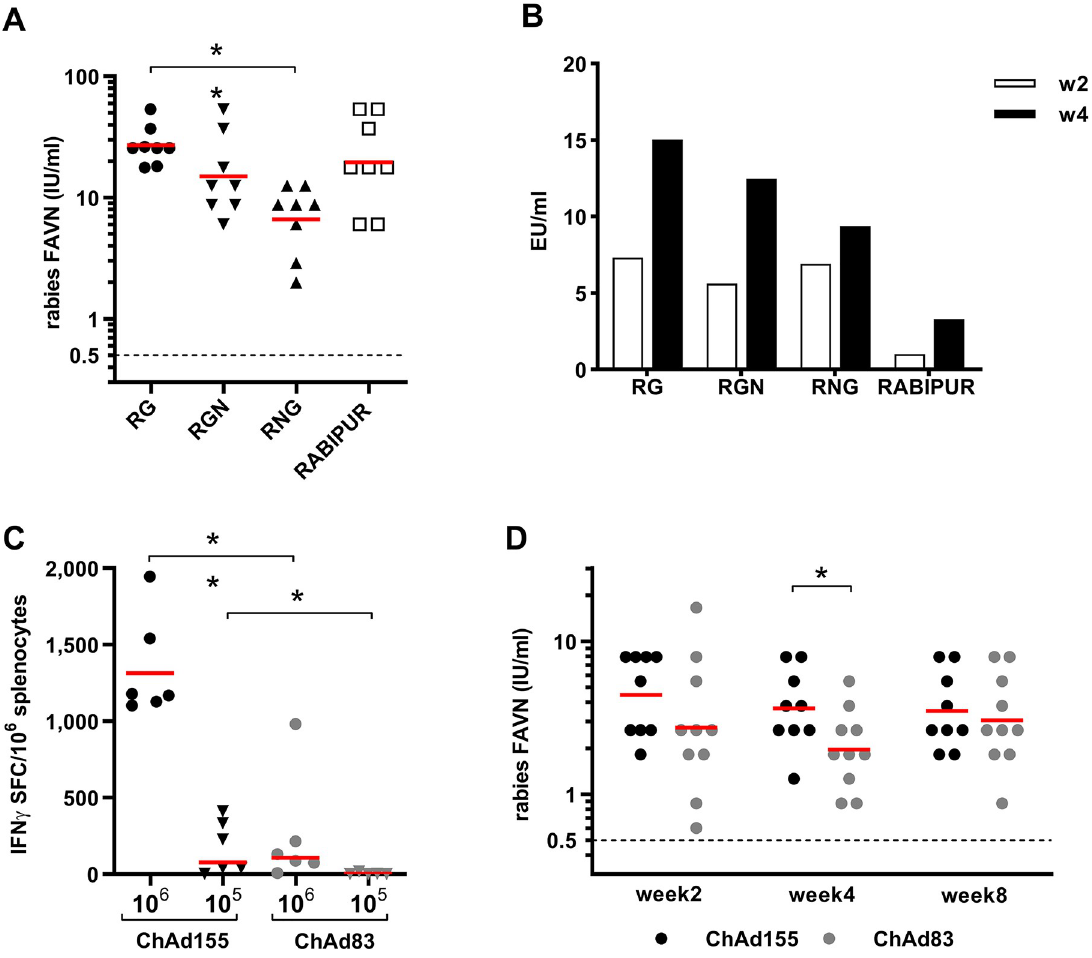
Fig 2. Immunological potency of ChAd155 and ChAd83 vectors in mice. A) Groups of CD1 mice (n = 8) were immunized with 1x10 8 vp of ChAd155-RG, ChAd155-RGN and ChAd155-RNG, encoding different rabies antigen designs. As a control, one group of animals received 1/10th of the human dose of RABIPUR. Sera were collected 2 and 4 weeks after vaccination. Rabies VNA were measured by FAVN assay in sera collected at w4, and expressed as International Units (IU)/ml. B) Anti-G protein IgG measured by a commercially available ELISA kit (Platelia) at week 2 and 4 after immunization C) Groups of BALB/c mice (n = 8) were immunized with either 1x10 5 or 1x10 6 vp of ChAd155-RG, or ChAd83-RG. At 4 weeks after vaccination animals were sacrificed and T cell response measured in spleen of individual mice by IFN γ ELISpot assay. Data are expressed as number of IFN γ spot forming cells (SFC)/10 6 splenocytes. D) BALB/c mice received 1x10 7 vp of either ChAd155-RG, or ChAd83-RG, and were bled 2, 4 and 8 weeks after. Rabies VNA were measured by FAVN assay, and expressed as IU/ml. In all panels, the red lines represent group geometric